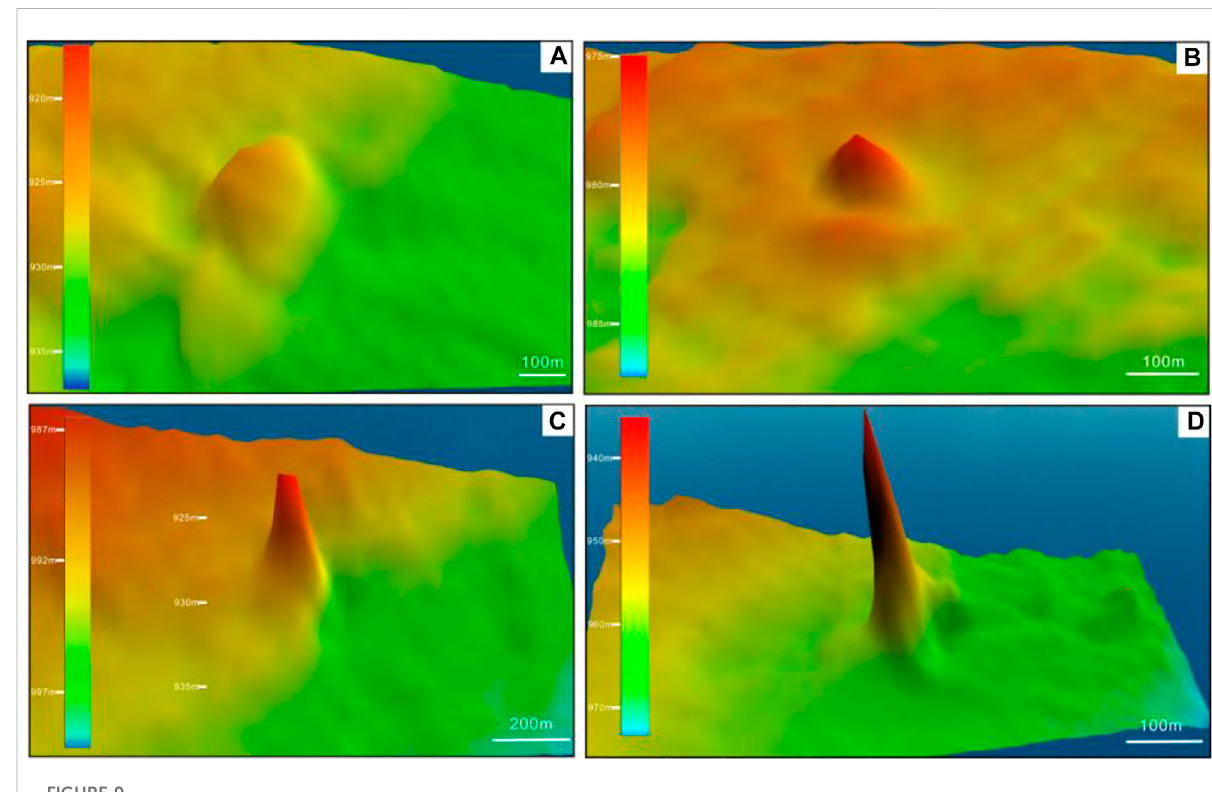
FIGURE 9 Mud volcanoes are surrounded by collapse subsidence structures. See locations in Figure